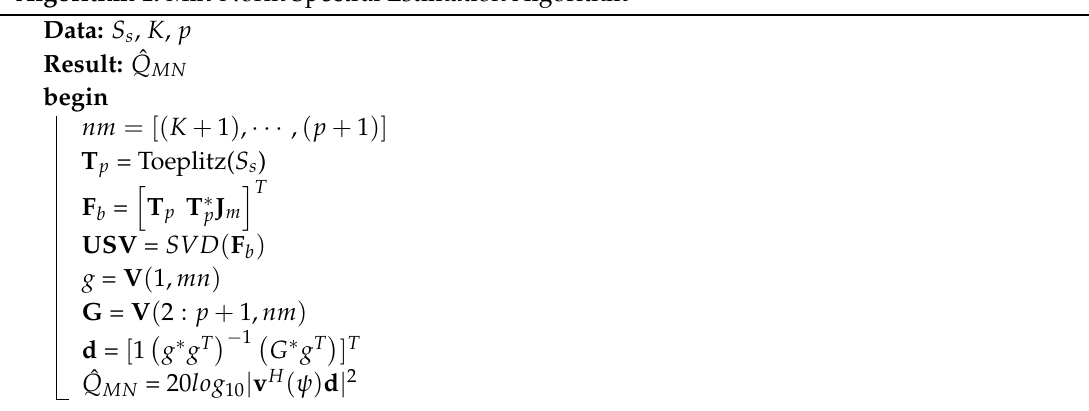
Algorithm 1: Min-Norm Spectral Estimation